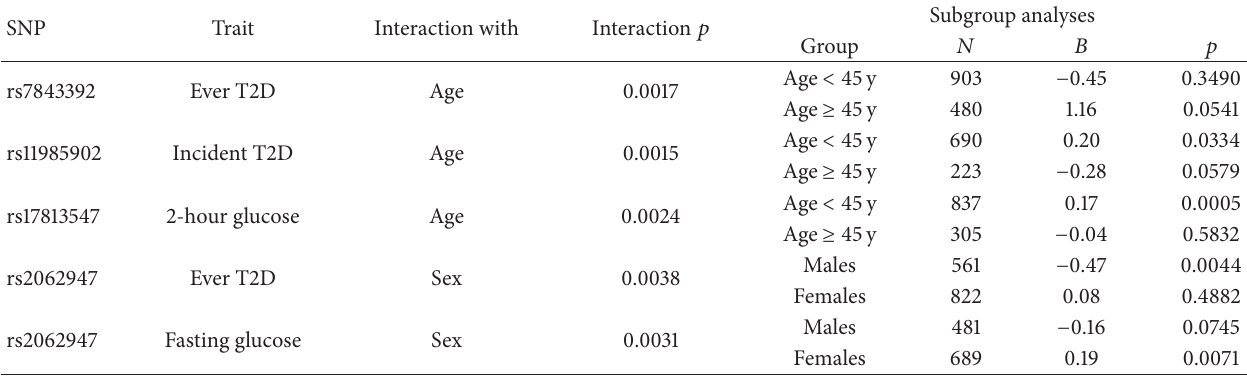
Table 2: SLC30A8 -related SNPs showing significant interaction with age or sex. SNP